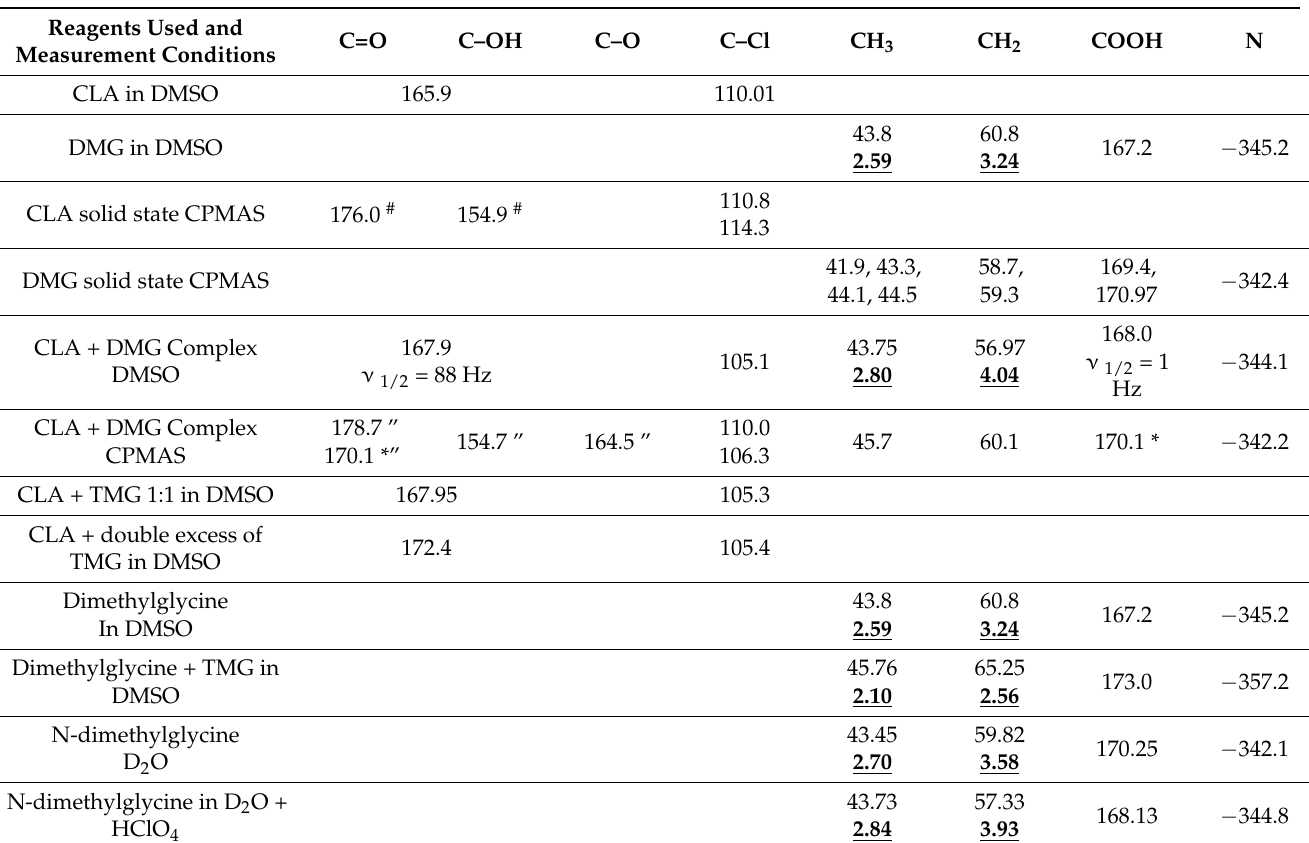
Table 4. NMR data for the N,N-dimethylglycine–chloranilic acid co-crystal